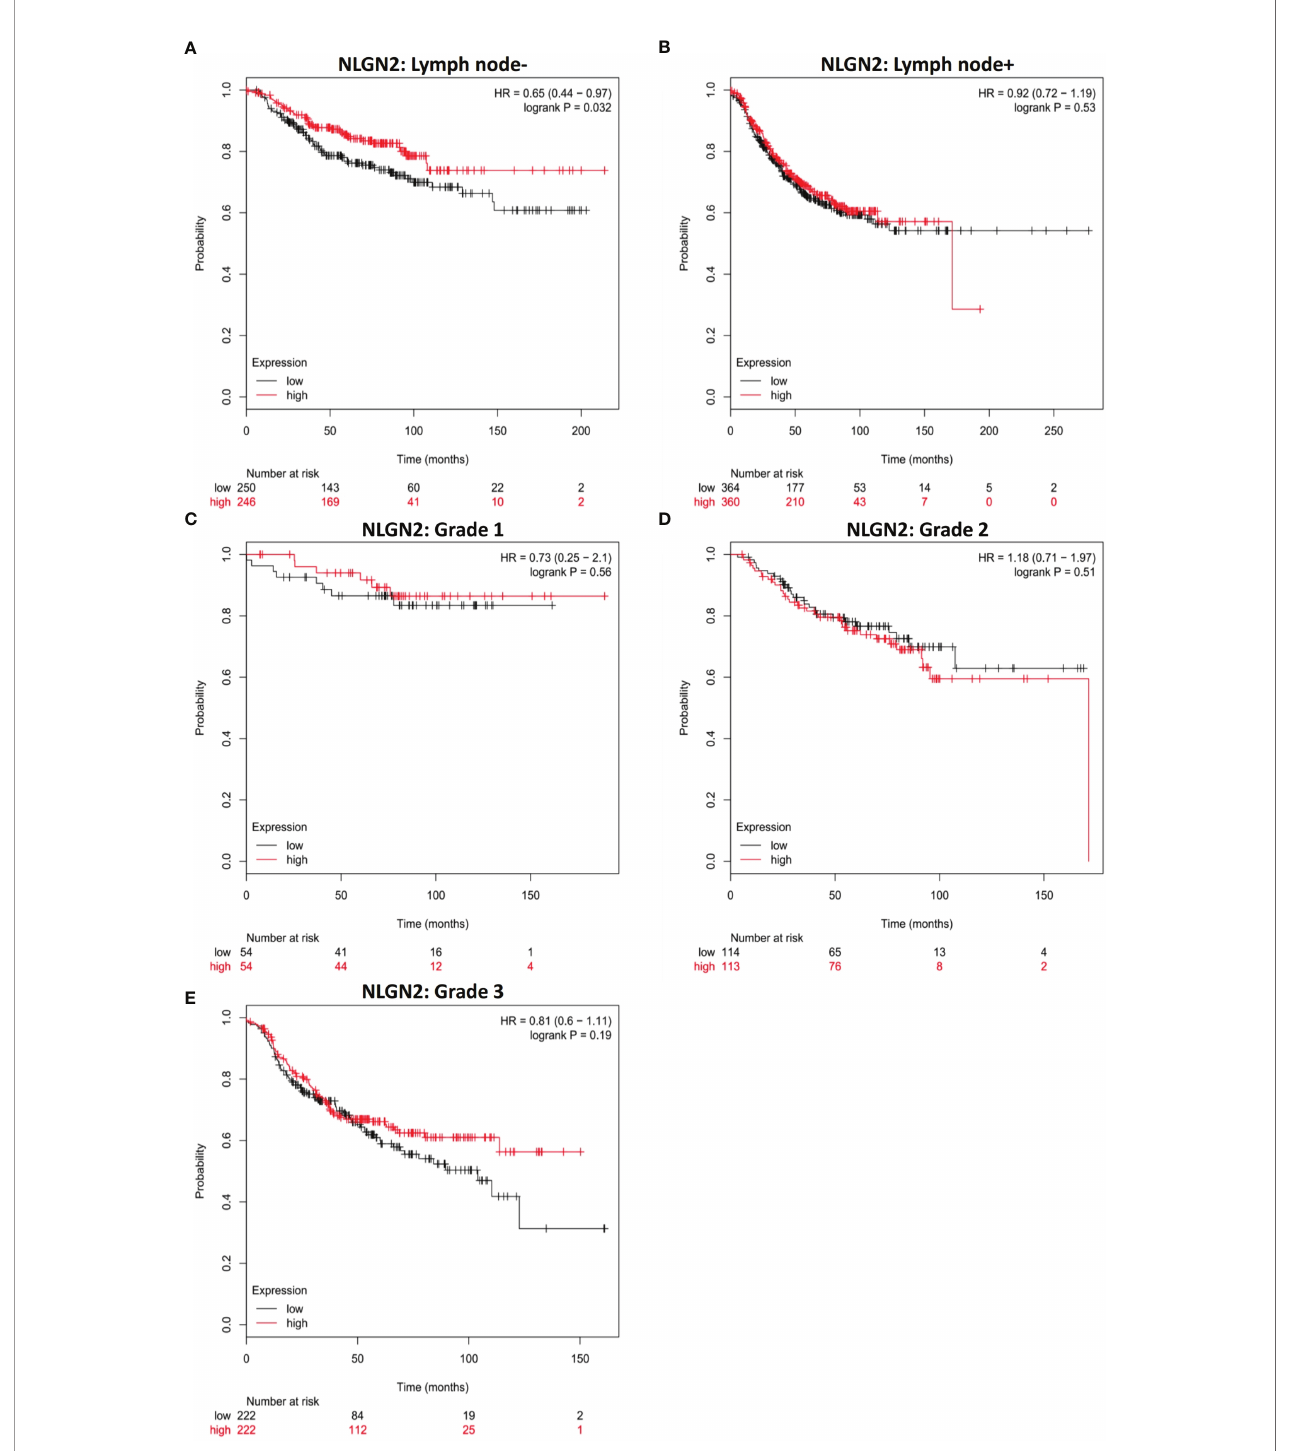
FIGURE 3 | NLGN2 is favorable in lymph node non-metastatic breast cancer patients. (A) Prognostic analysis of NLGN2 in lymph node- breast cancer. (B) Prognostic analysis of NLGN2 in lymph node+ breast cancer. (C) Prognostic analysis of NLGN2 in Grade 1 breast cancer. (D) Prognostic analysis of NLGN2 in Grade 2 breast cancer. (E) Prognostic analysis of NLGN2 in Grade 3 breast cancer. The HR and log rank p values are indicated in each panel, and p < 0.05 is statistically signi fi